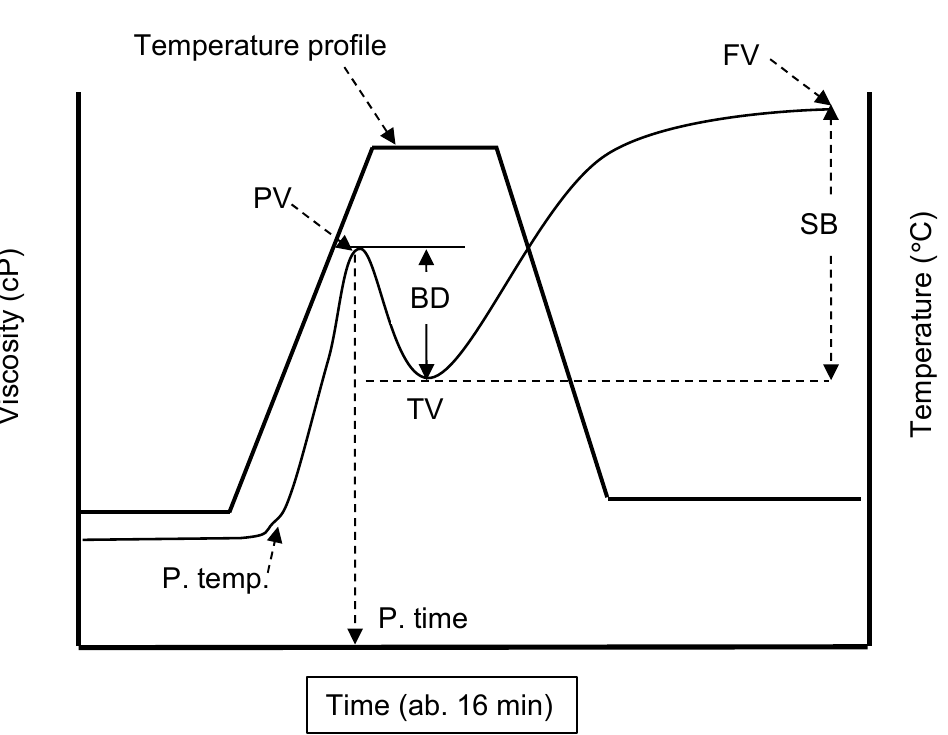
Figure 2. Pasting profile of Dioscorea rotundata starch using a Rapid Visco Analyser (RVA). P. temp., pasting temperature; P. time, peak time; PV, peak viscosity; TV, trough viscosity; BD, breakdown; FV, final viscosity; SB, setback.